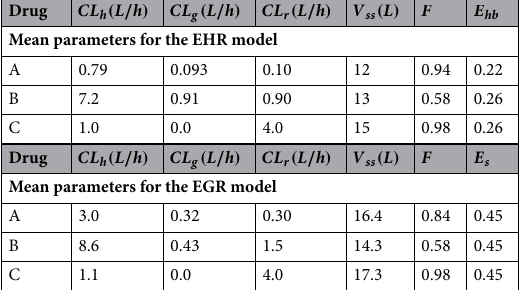
Table 3. Pharmacokinetic characteristics defined for each drug type to conduct the sensitivity analysis of drug reabsorption in EHR and EGR models. CL h : hepatic clearance; CL g : intestinal clearance, including excretion and gut-wall mediated metabolism; CL r : renal clearance; V ss : volume of distribution at steady state; F : oral bioavailability; E hb : fraction of intra-hepatocytic drug that is submitted to hepatobiliary secretion; E s : fraction of drug extracted to the stomach lumen from the parietal